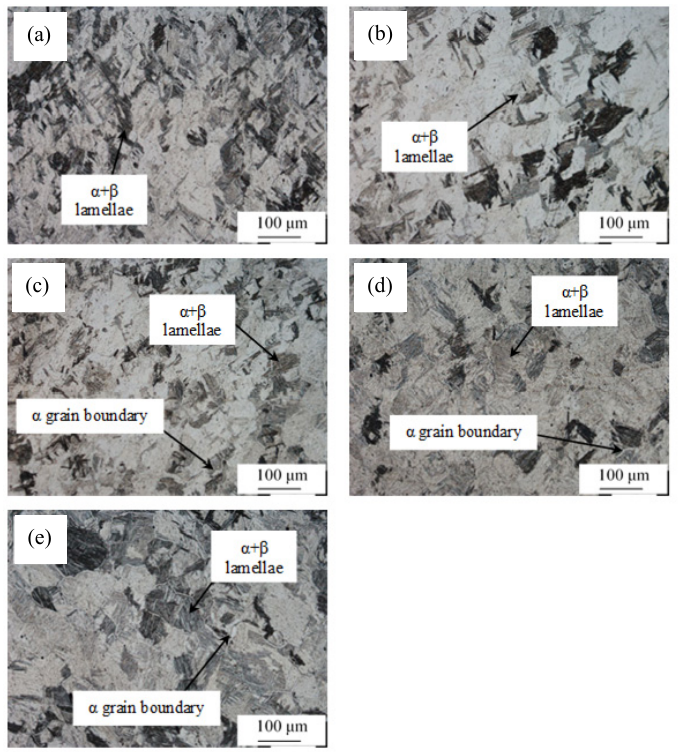
Figure 2. Microstructure of the Ti-5Al-2.5Fe billets forged at 1250 °C subjected to β annealing at 750 °C with different aging times: ( a ) 2 h, ( b ) 4 h, ( c ) 6 h, ( d ) 8 h, and ( e ) 10 h.